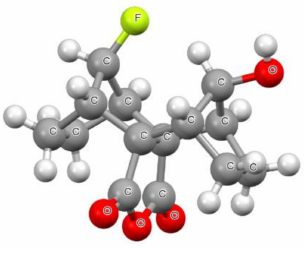
Figure 3. The fluoronium ion precursor from the crystal structure [50], BEXNOJ refcode.